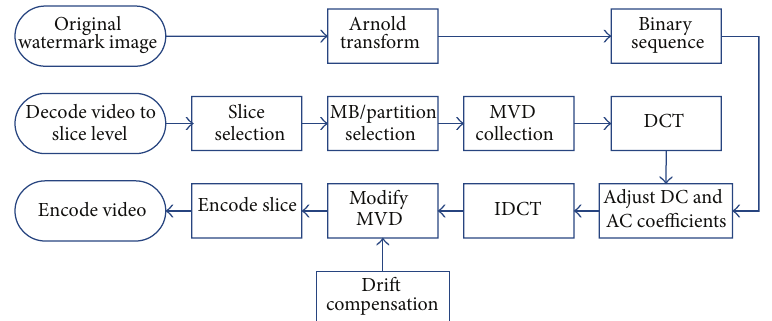
Figure 7: Watermark embedding approach.